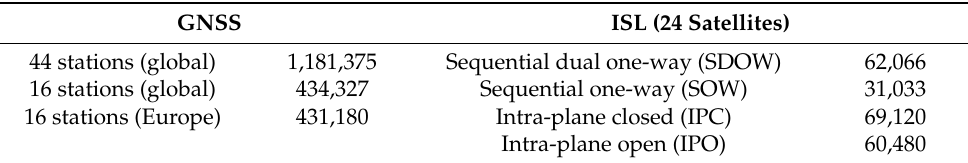
Table 2. Number of GNSS and ISL measurements for 1